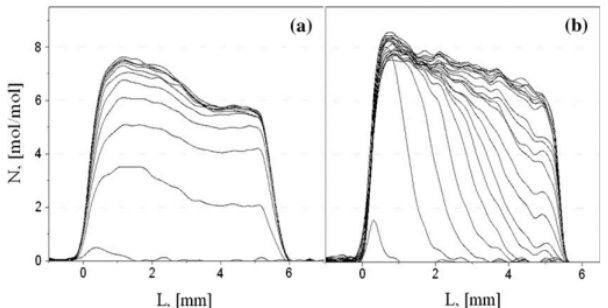
Figure 4. 1D distribution of adsorbed water in the layer of composite sorbent CaCl 2 /Al 2 O 3 composed from the grains of different sizes d g = 0.25–0.5 mm ( a ) and 0.04–0.056 mm ( b ). The binder (pseudoboehmite) content 5 wt.%. Reprinted/adapted with permission from Ref. [77]. (Copyright 2010), Elsevier.